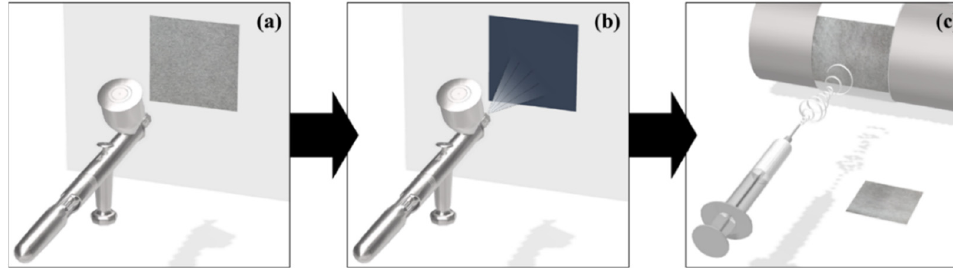
Figure 1. Illustration of the MWCNT composite conductive nonwoven preparation: ( a ) CNwCa, ( b ) MWCNT spraying process, and ( c ) electrospinning process.